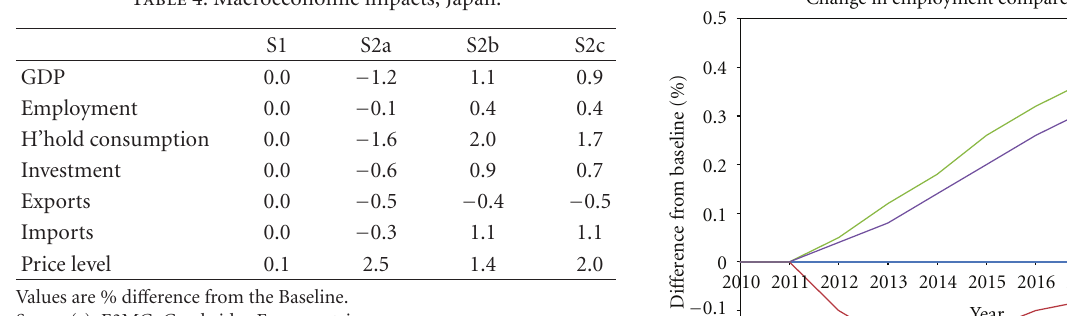
Table 4: Macroeconomic impacts, Japan.